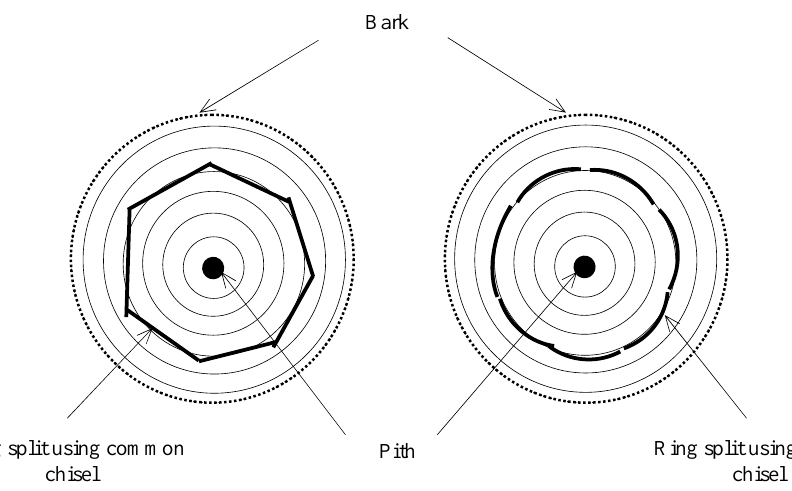
Fig. 5. Schematic view of ring splitting using two tools: common and arched